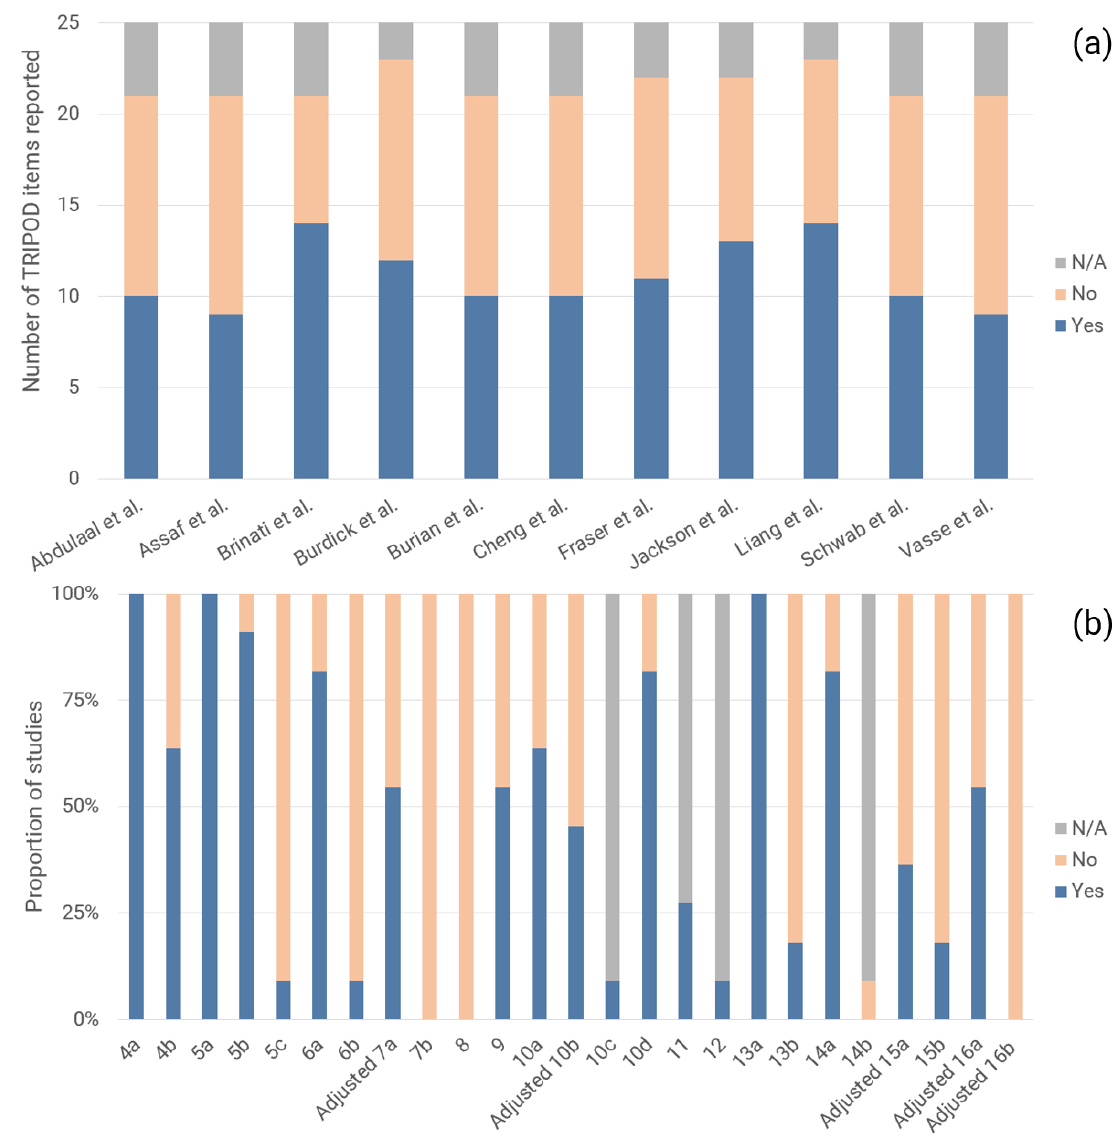
Figure 2. ( a ) Number of TRIPOD items reported per study and ( b ) Proportion of studies reporting on each TRIPOD item.